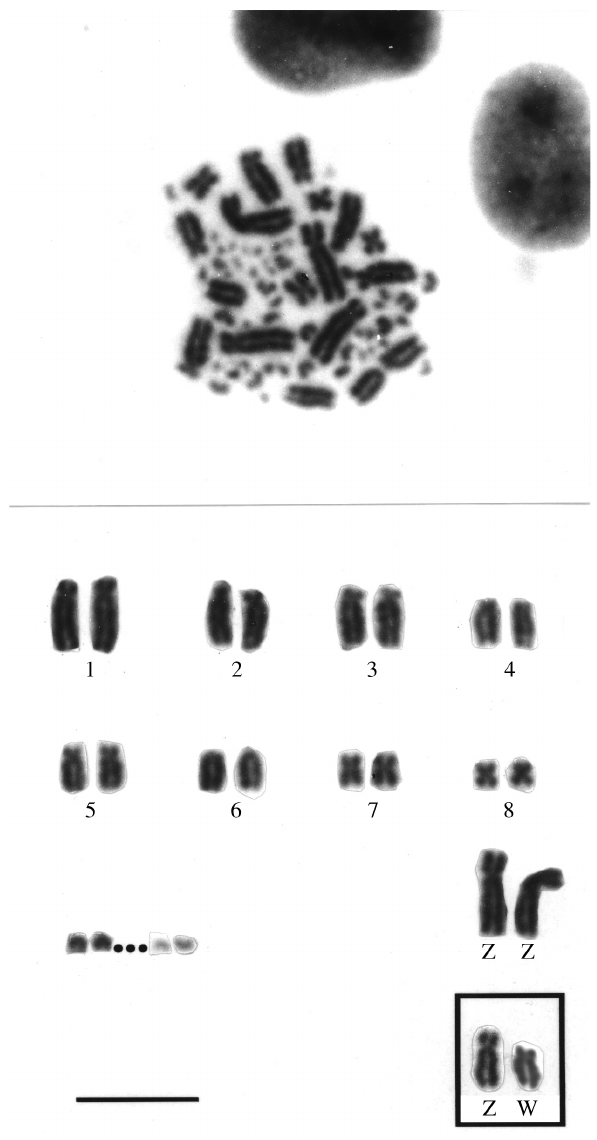
Figure 4 - Conventionally stained mitotic metaphase and male karyotype showing the macrochromosomes and the first and last pairs of microchromosomes of Salvatoria xanthops , in conventional staining. In the insert, the ZW female sex chromosomes. Bar = 10 µ